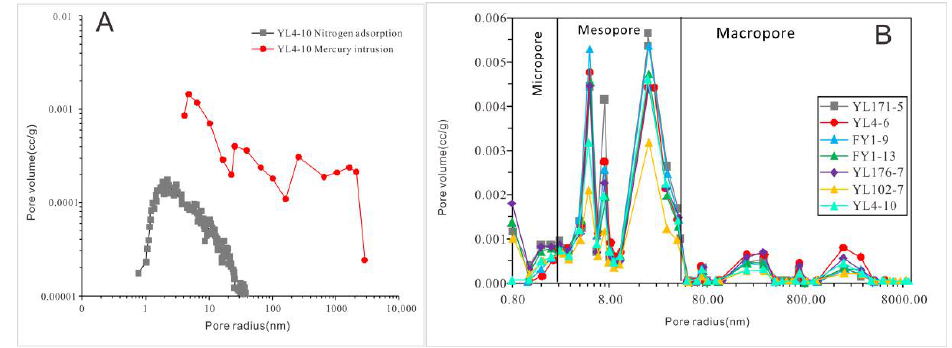
Figure 10. N 2 adsorption and mercury porosity distribution diagram (YL4-10) ( A ) and shale N 2 adsorption-high pressure mercury injection full pore size distribution ( B